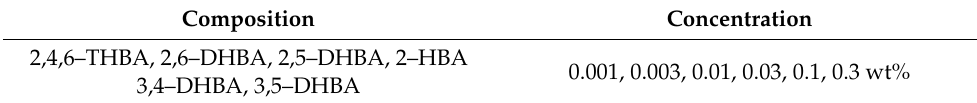
Table 2. Concentrations of modification solutions.